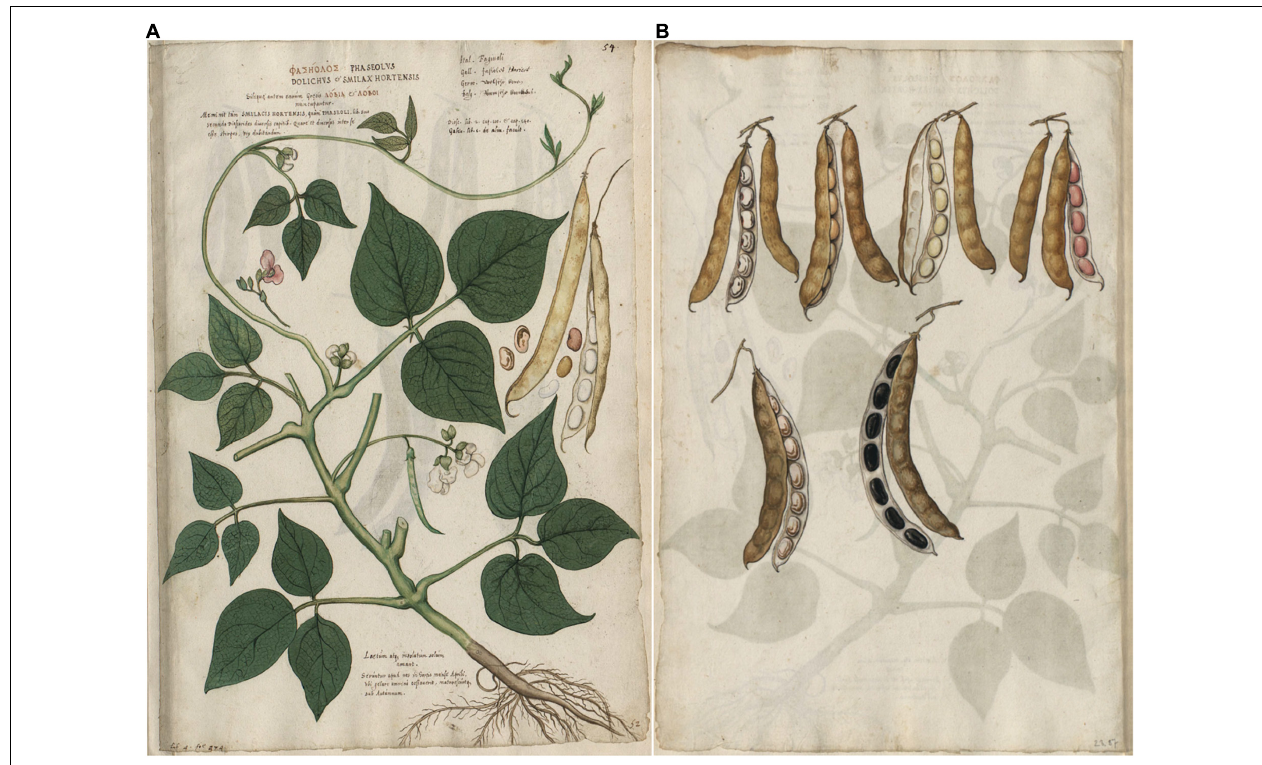
FIGURE 8 | Two plates from Libri Picturati (1550–1595) of common beans. (A) Plant with a detached pod. (B) Pods from different plants showing diversity in seed and pod shape and color. Source: Public domain; Biblioteka Jagiello´nska, Kraków, PL.